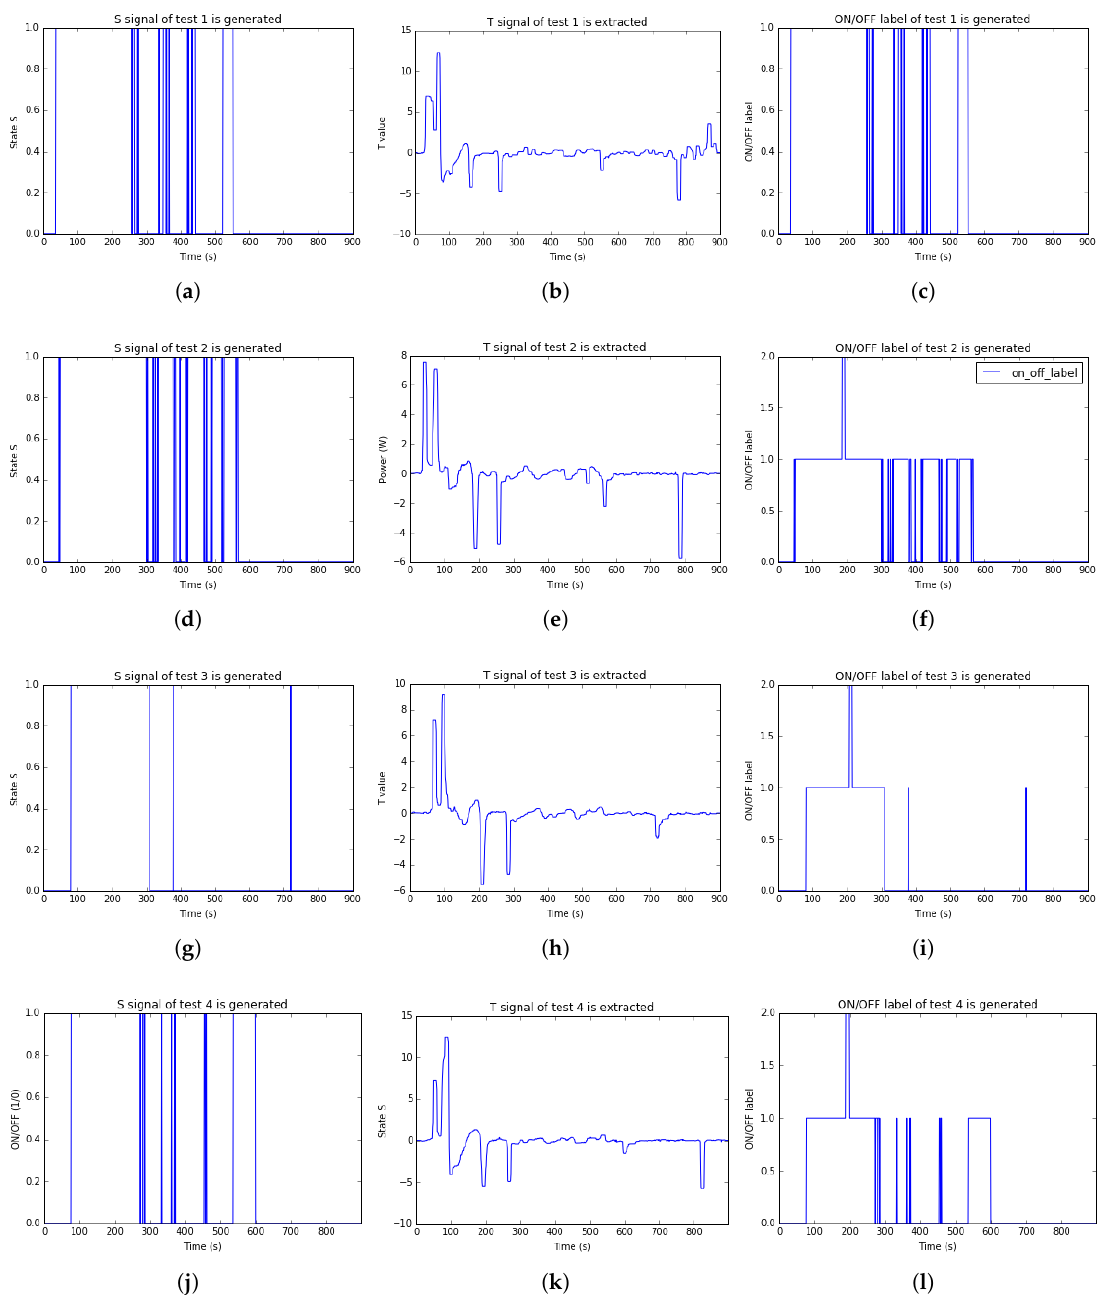
Figure 13. State S , T & ON/OFF label signals of test 1 to test 4 data: ( a – c ) test 1; ( d – f ) test 2; ( g – i ) test 3; ( j – l ) test